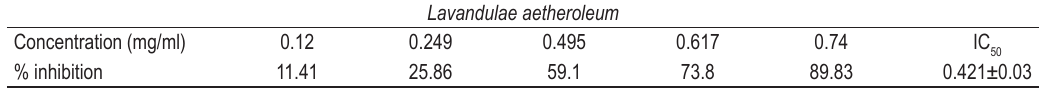
TABLE 3. Percentage of neutralization of DPPH• of essential oil of L. angustifolia Lavandulae aetheroleum